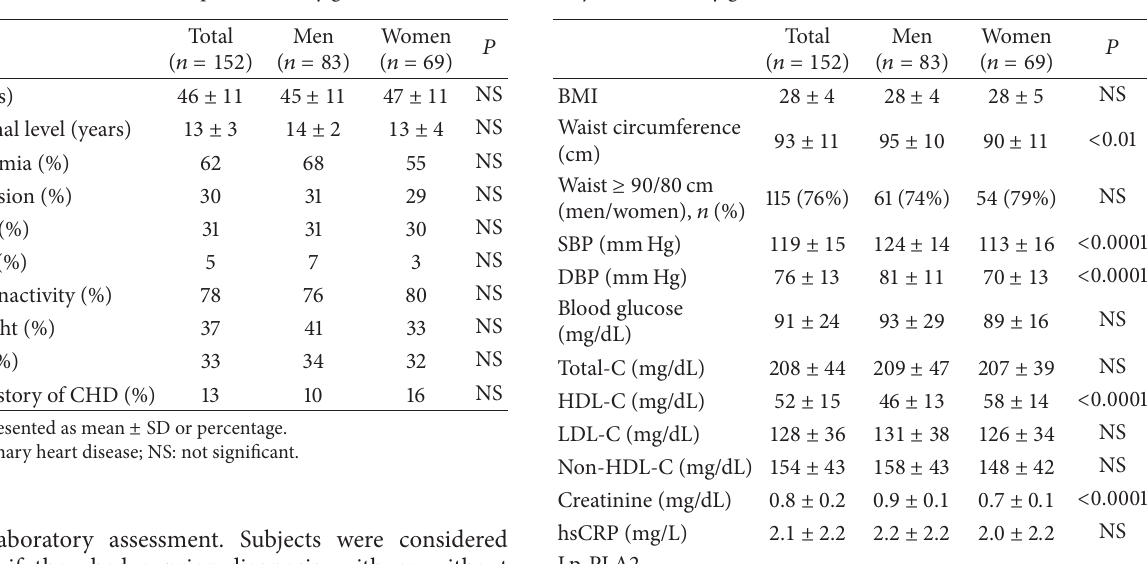
Table 1: Demographic data and prevalence of traditional cardiovas- cular risk factors in the total sample divided by gender.